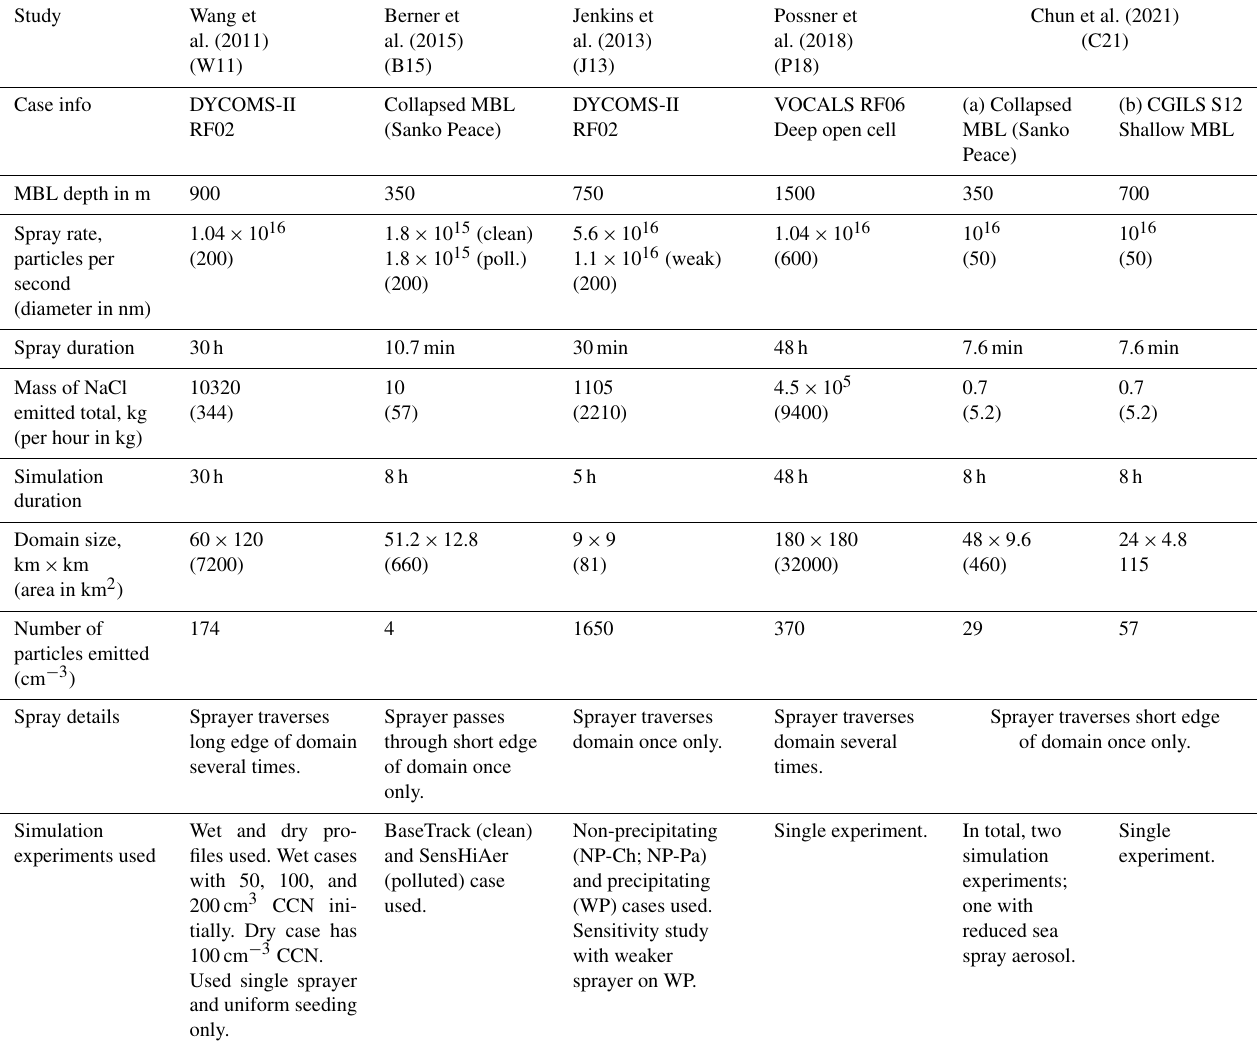
Table 2. Large eddy simulation studies included in this study. Information included in this table focused on highlighting diversity in injected particles and domain